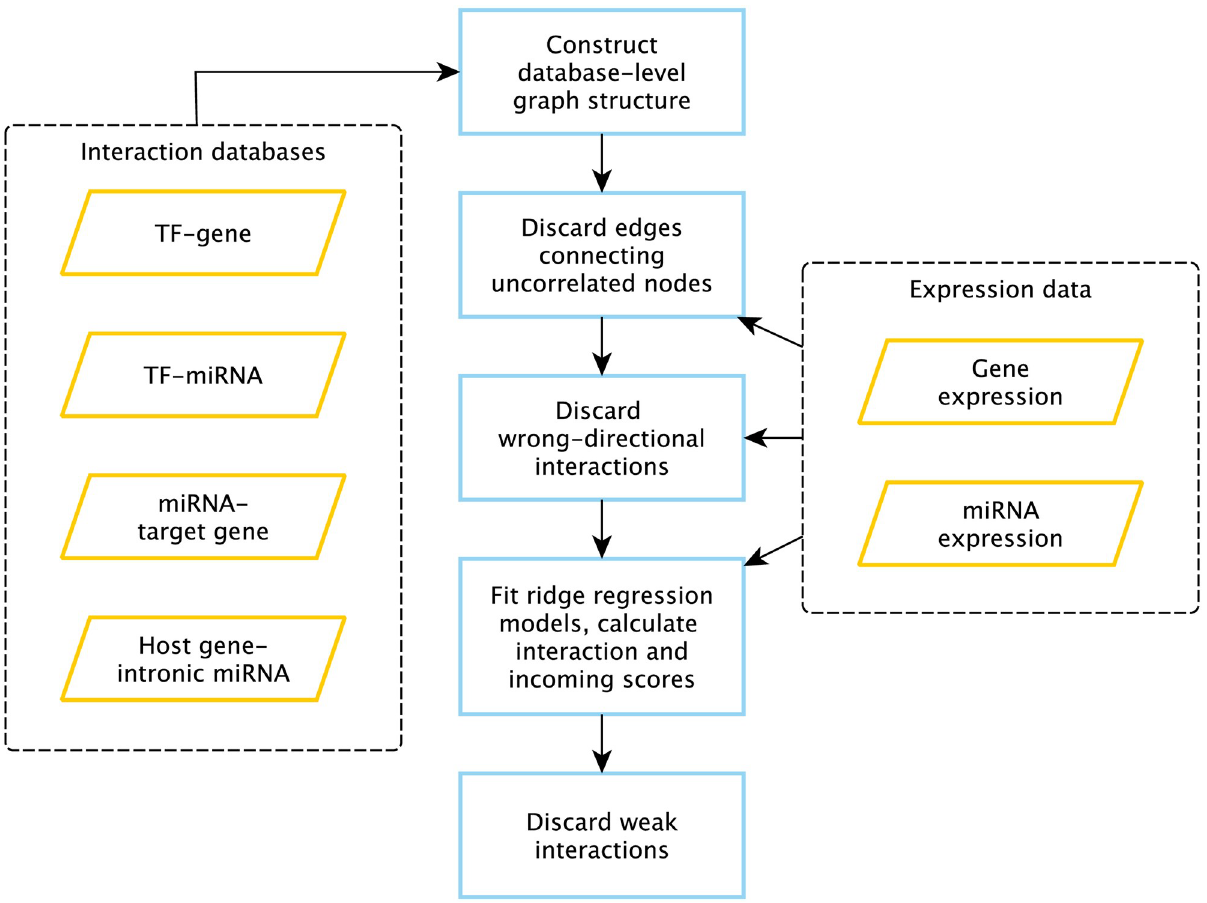
Fig 1. Workflow of miRGTF-net. Blue-framed rectangles represent processes, orange-shaped parallelograms represent input data.